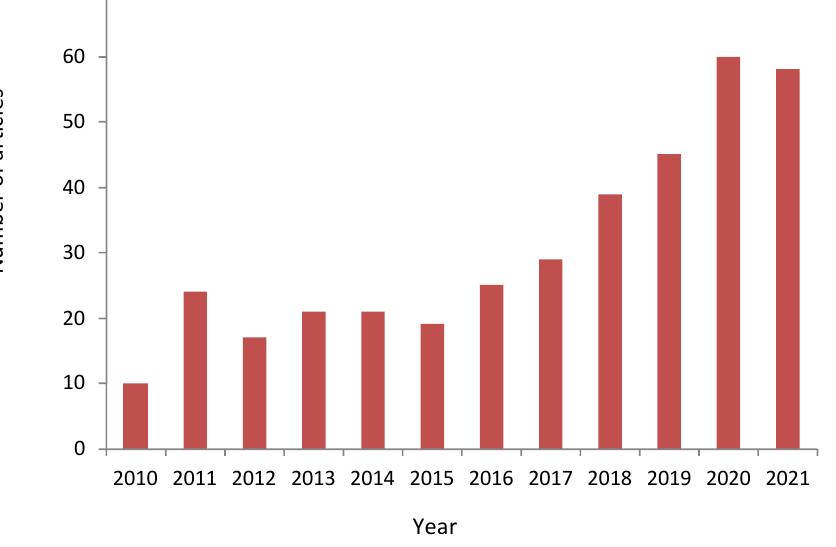
Figure 2. Evolution of the number of works published in Scopus using “beer” and “sensory analysis” as keywords.